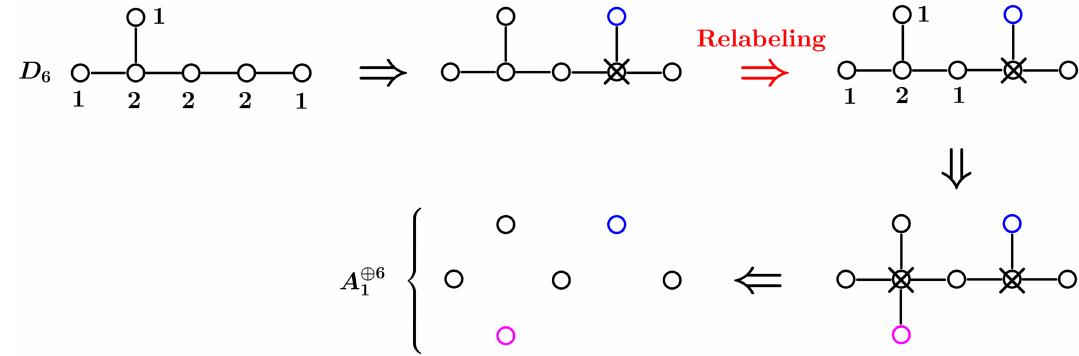
JHEP10(2022)124